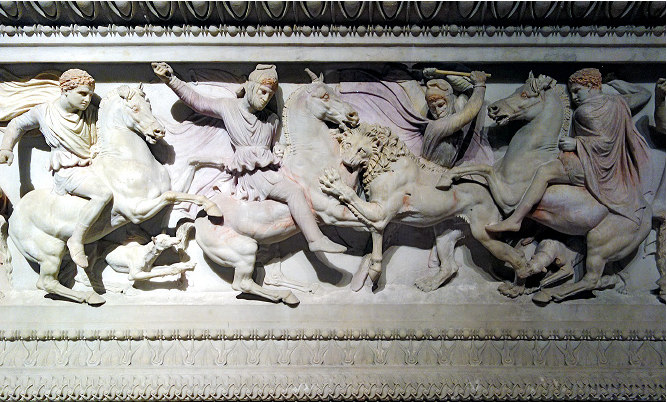
Figure 30. Lion hunt scene on so-called Alexander sarcophagus (IAM inv. no. 72); marble; Sidon, Phoenicia (mod. Lebanon); Hellenistic, ca. 330–310 BCE [photography by Steven Zucker; CC BY-NC-SA 2.0 License].